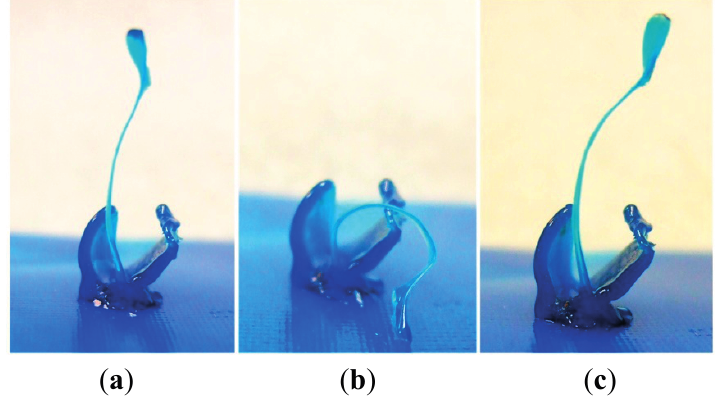
Figure 2. The SME in poly(lactic acid) (PLA). ( a ) original shape; ( b ) after deformation; and ( c ) after heating in hot water.